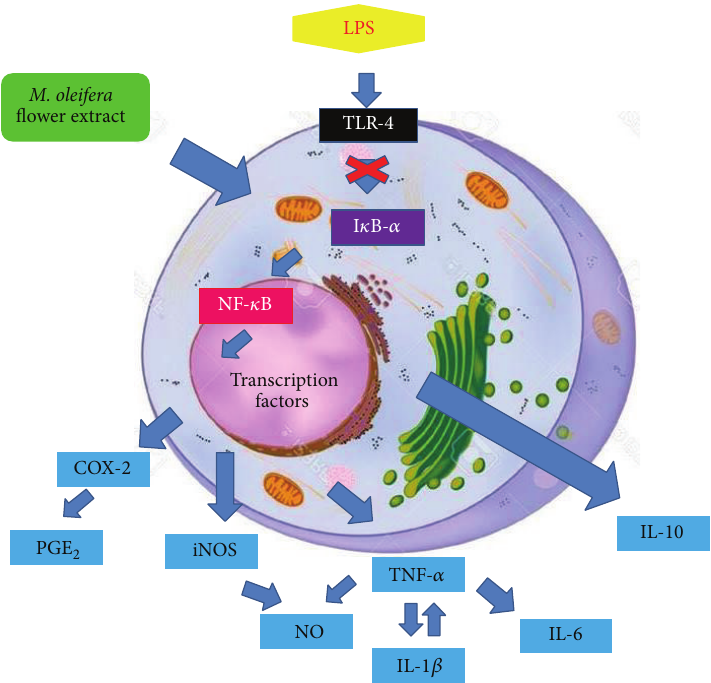
Figure 7: Mechanism blockade of NF- 𝜅 B activation in RAW 264.7 macrophages by 80% hydroethanolic M. oleifera flower